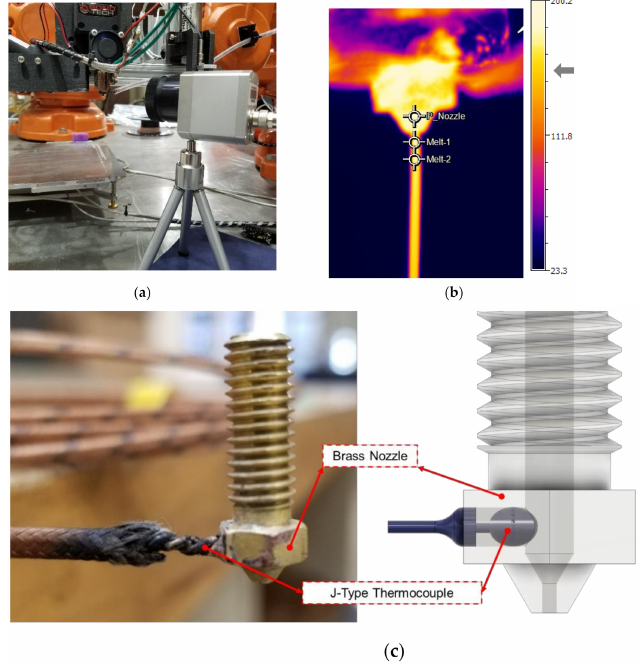
Figure 3. ( a ) IR camera setup for measurement of the polymer exit temperature ( b ); IR image showing locations of crosshairs; ( c ) Modified brass nozzle with